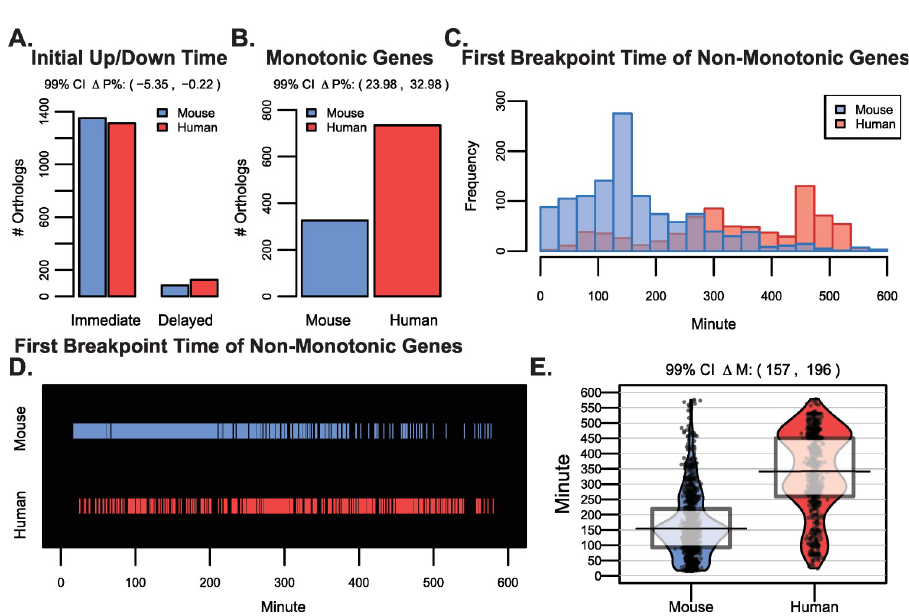
Fig 2. Initial human and mouse ortholog expression trends begin at similar times yet last for longer in human. A) The number of genes having an up or down trend occurring immediately versus those displaying a delayed trend is shown. The two mouse/human bars represent genes having either immediate or delayed dynamics. The 99% confidence interval for the difference in the percent ( Δ P%) of orthologs having an immediate up/down trend was -5.35% to -0.22%. B) The number of orthologs that had monotonic expression patterns (i.e. no breakpoints) along the time courses. The 99% confidence interval for the difference in the percent ( Δ P%) of monotonic orthologs in human versus mouse was 23.98% to 32.98%. C) For non-monotonic genes (i.e. those having at least one breakpoint), histograms of the first breakpoint time are shown for mouse and human genes. D) Similar to C), the time of the first breakpoint is highlighted in either blue or red for mouse and human orthologs. E) The first breakpoint times for mouse and human orthologs are represented as smoothed densities (bean plots) with overlaid raw data, the median, and a box representing the interquartile range. The 99% confidence interval on the paired Wilcoxon rank sum statistic for shift in distribution ( Δ M) was 157 to 196